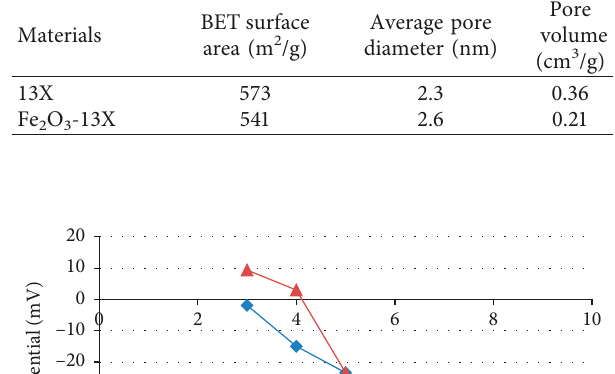
Table 2: The texture properties of 13X and Fe Materials